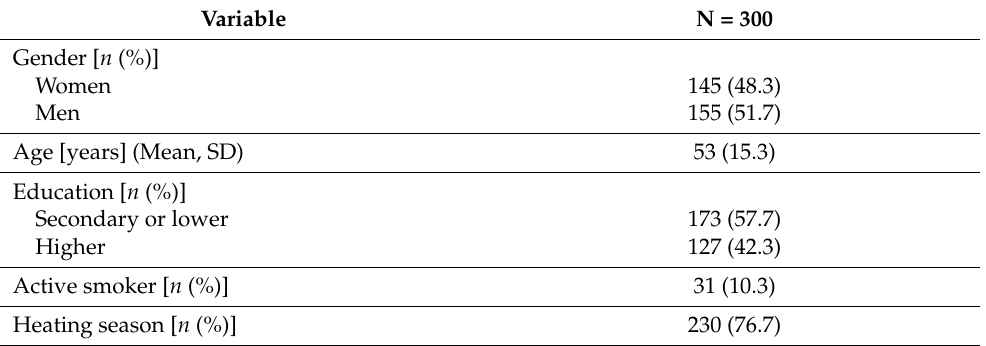
Table 1. Characteristics of the study cohort.